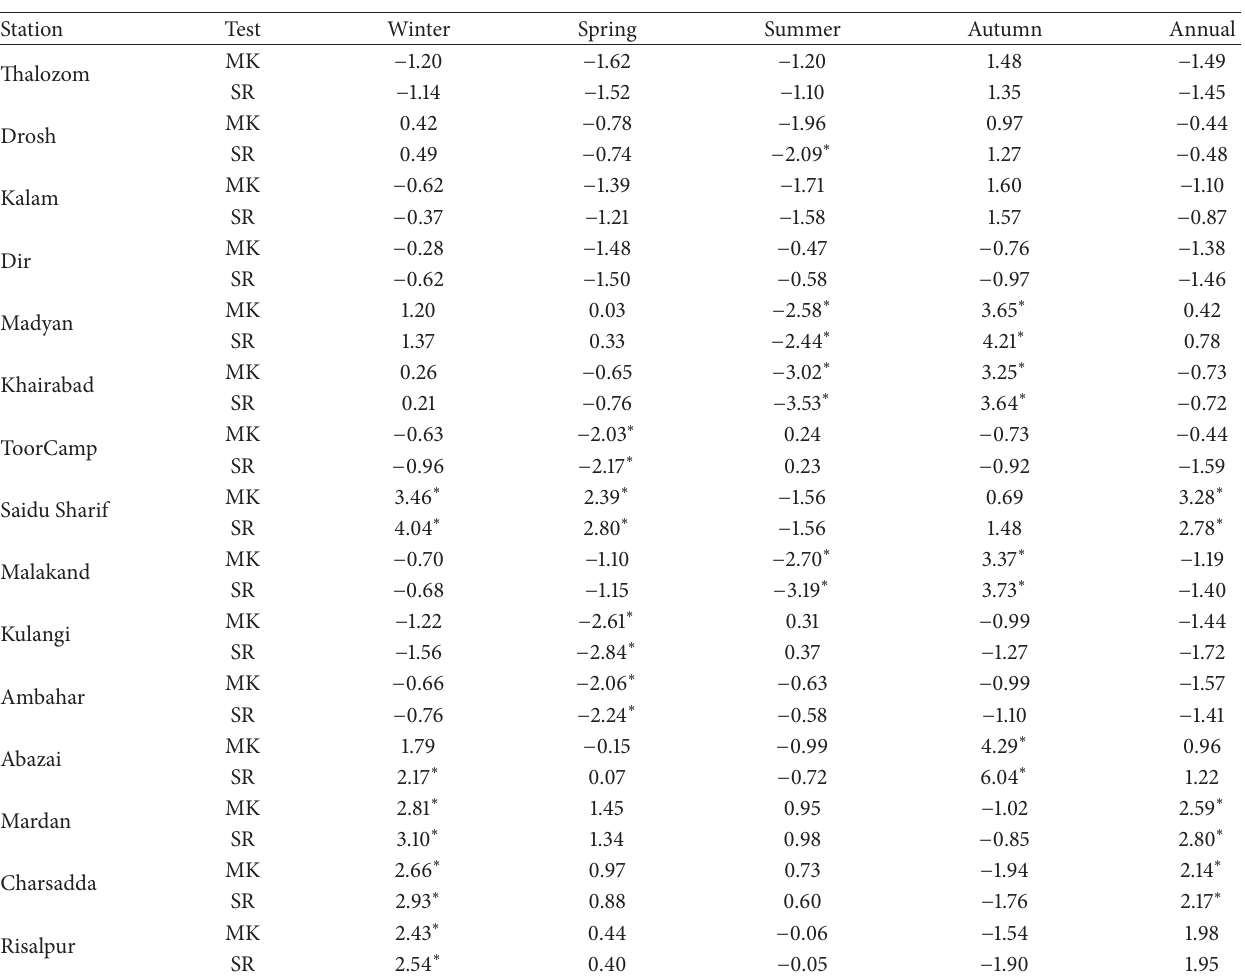
Table 4: MK and SR tests results for precipitation in seasonal and annual time